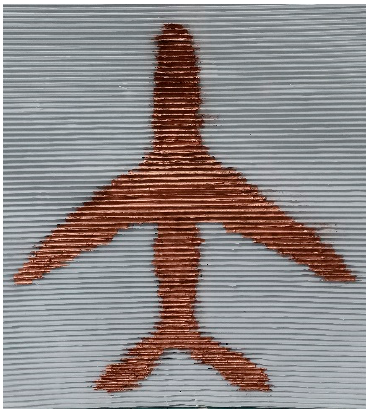
Figure 8. The painted plane model used in the experiments.